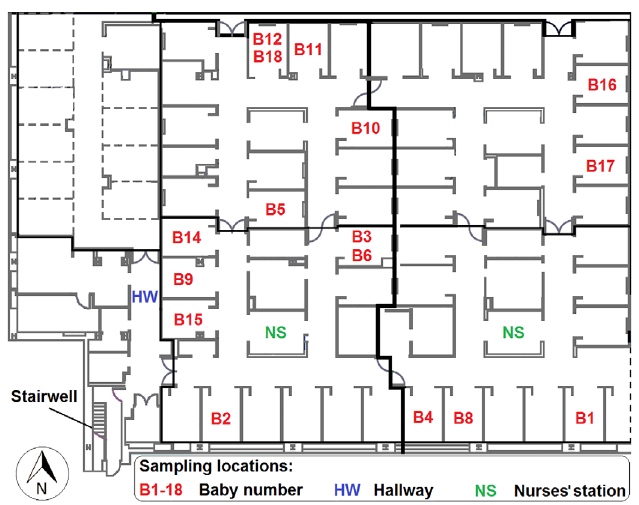
Fig 1. Schematic layout of the NICU, located on building level 1 and served by its own air-handling unit. Most of the NICU patient rooms were similar in size (about 33 m 3 ). Sampling sites were in baby rooms (red), hallway (blue) and nurses ’ stations